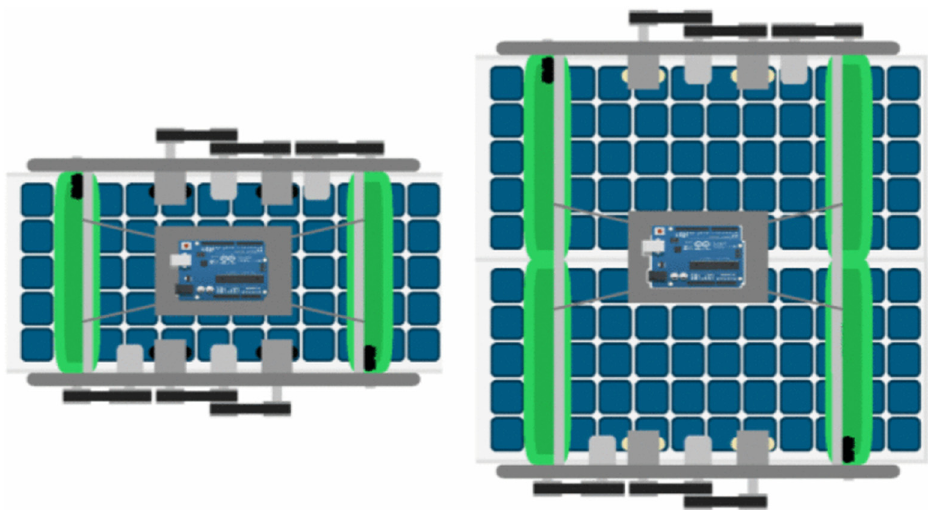
Figure 42. Prototype of a robotic cooling system for PV panels [165]. Table 8. Summary of the different cleaning methods noted in the literature for PV systems.